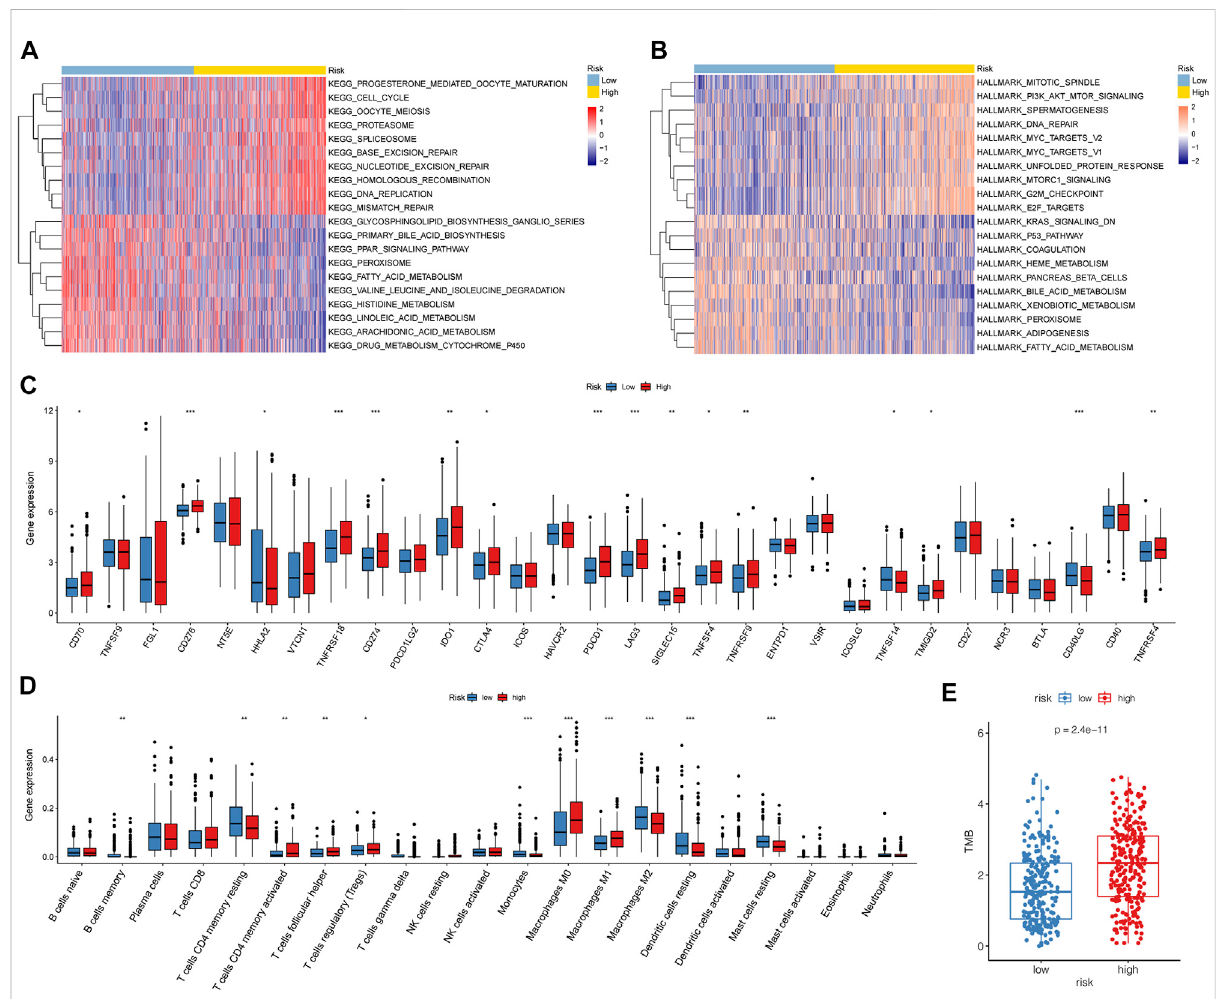
FIGURE 7 Biological characteristics, pathways, and immune-related analyses between high- and low-risk groups. (A,B) Heatmaps of GSVA between the differentriskgroupswithC2andhallmarkgenesets. (C) Boxplotsillustratingexpressionofimmunecheckpointsofthehigh-andlow-riskgroups. (D) Boxplots illustrating abundance of immune cells in the high- and low-risk groups. Red boxes: high-risk group; blue boxes: low-risk group. (*: p < 0.05, **: p < 0.01, and ***: p < 0.001). (E) High-risk group had higher TMB than the low-risk group ( p = 1e-11).